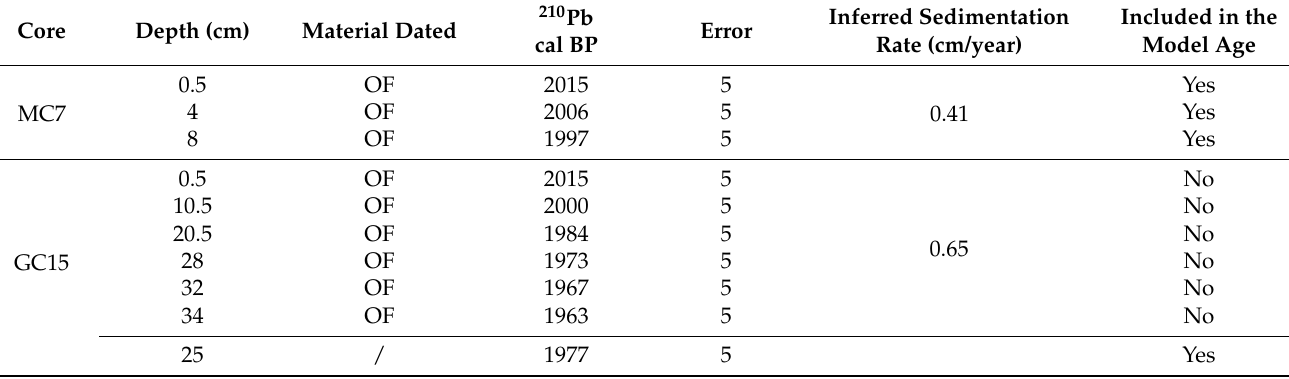
Table A1. Results of the 210 Pb dating on MC7 and GC15 by the EPOC laboratory (University of Bordeaux, France). The dating at 25 cm depth in GC15 was derived from the other 210 Pb